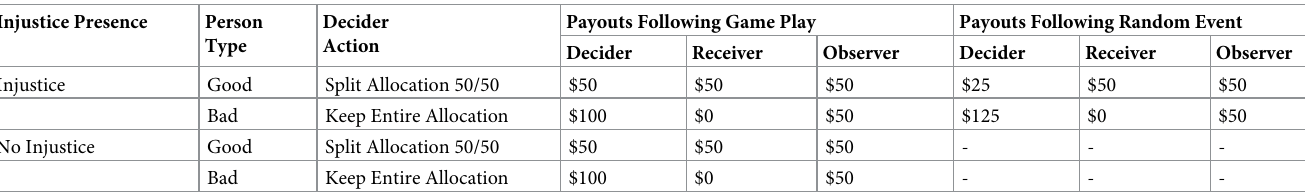
Table 1. Study 1 summary of actions and